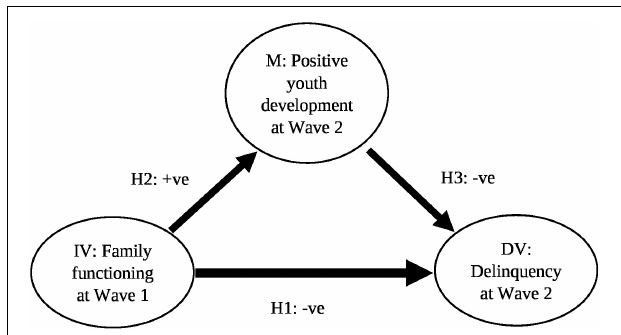
FIGURE 1 | Conceptual model for the mediating effect of positive youth development at Wave 2 on the path from family functioning at Wave 1 to delinquency at Wave 2. Note: IV, independent variable; M, mediator; DV, dependent variable; +ve, hypothesized positive relationship; and − ve, hypothesized negative